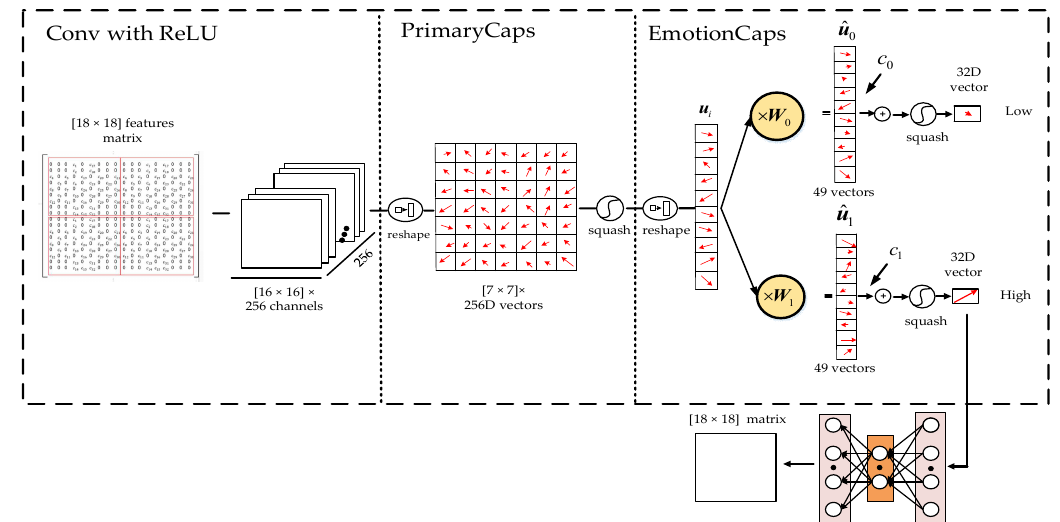
Figure 6. Architecture of the capsule network (CapsNet)-based model . ReLU: rectified linear unit.